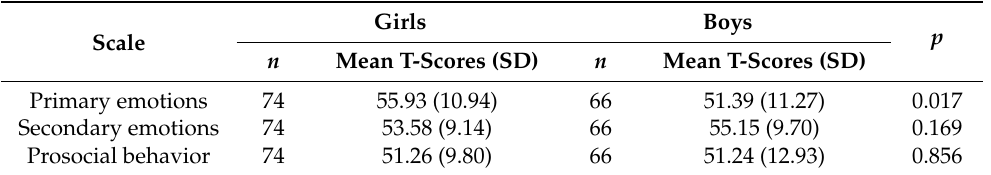
Table 4. Results of the distribution of the scores of the EMK 3–6 scales (emotional and social competences) in boys and